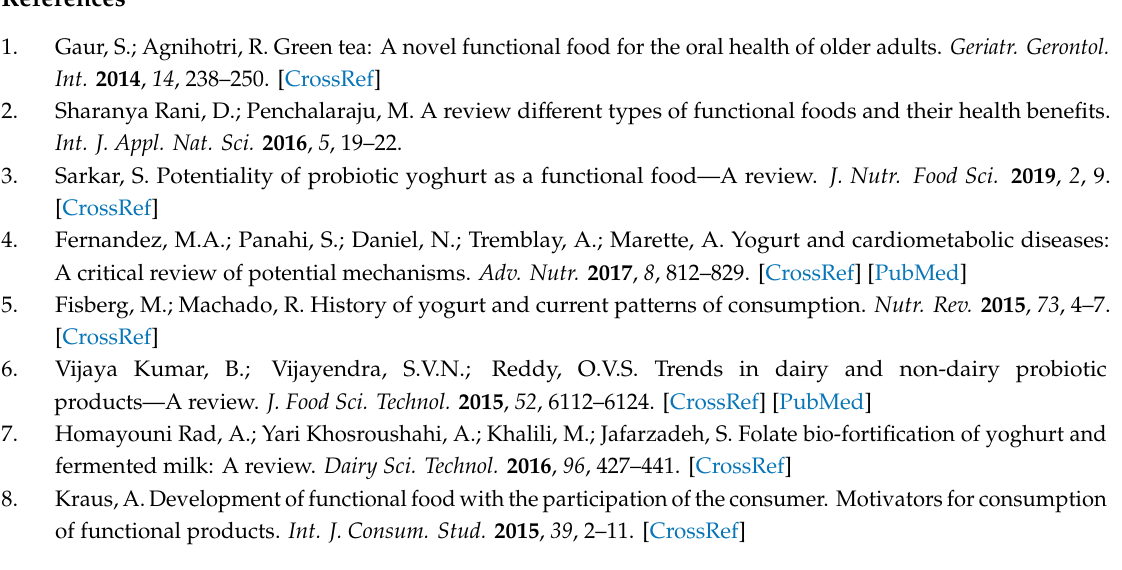
Table S1: Sensory attribute for yoghurts profiling, their definitions and intensity range, Table S2: Sensory characteristics of yoghurts evaluated by experts: C—Control, G—Green tea, B—Black tea, O—Oolong tea, M—Lemon balm- the mean values, 2 sessions ( n = 20), Table S3: Acceptability of yoghurts and willingness to buy evaluated by consumers: C—Control, G—Green tea, B—Black tea, O—Oolong tea, M—Lemon balm- the mean values ( n =